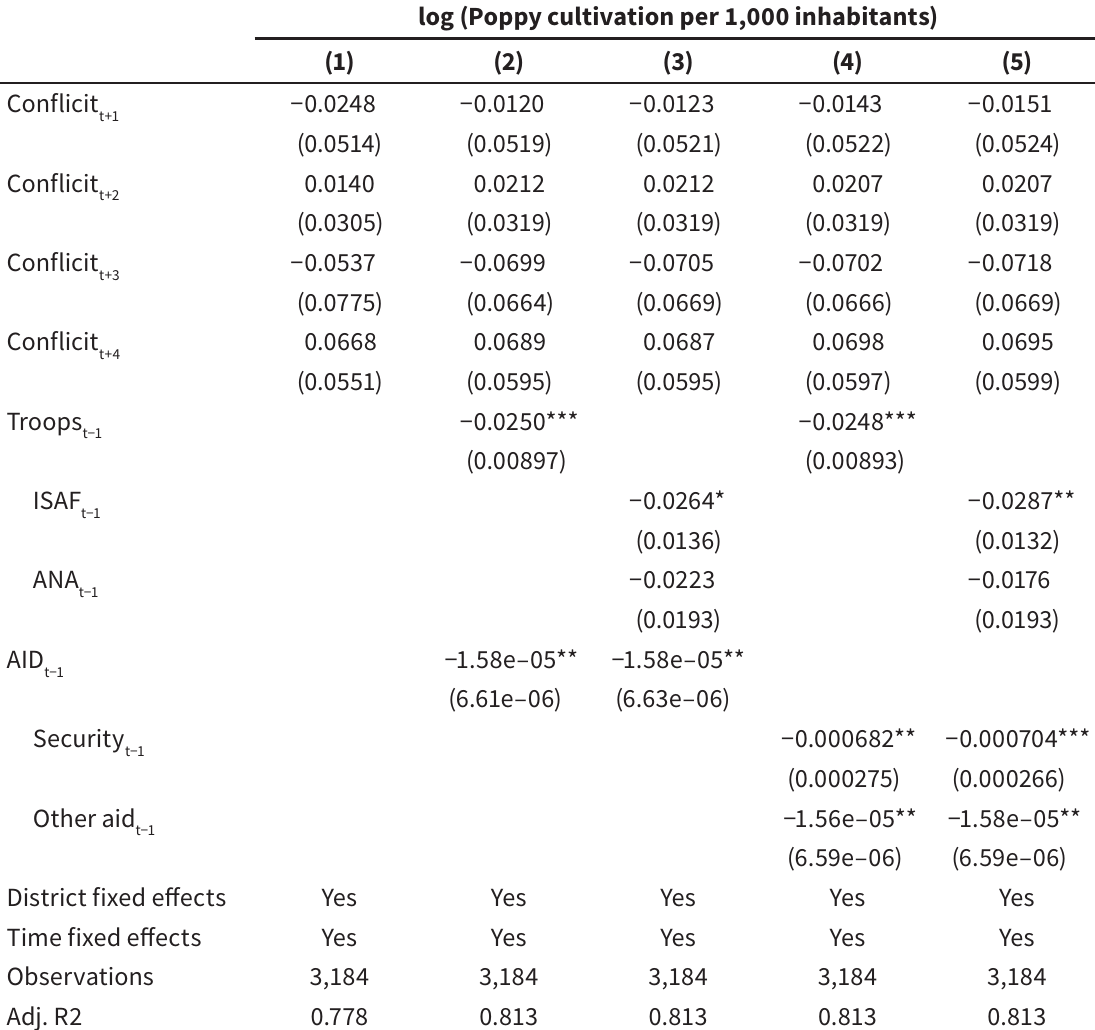
Conflict and land devoted to poppy cultivation (placebo test) log (Poppy cultivation per 1,000